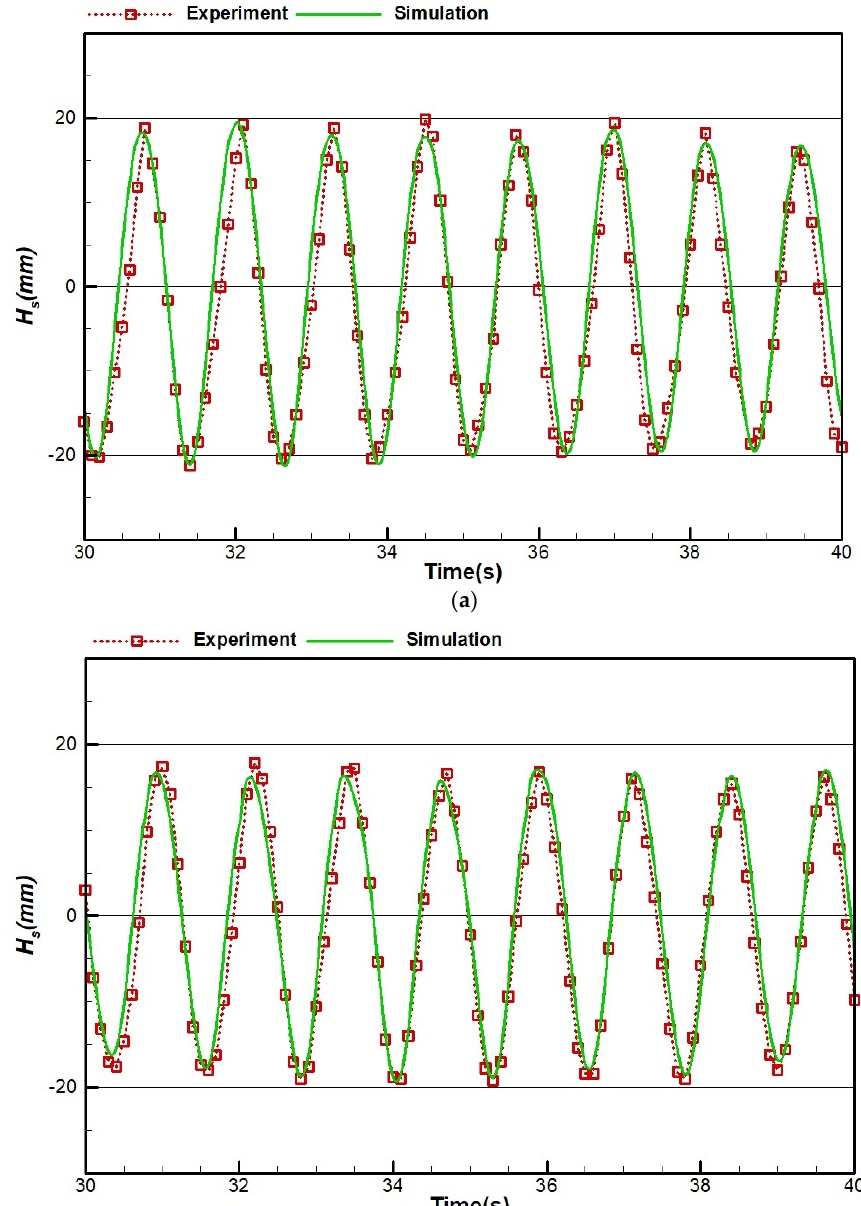
Figure 22. Wave height of case 5 at distances of ( a ) 3 m and ( b ) 5 m from the flap.